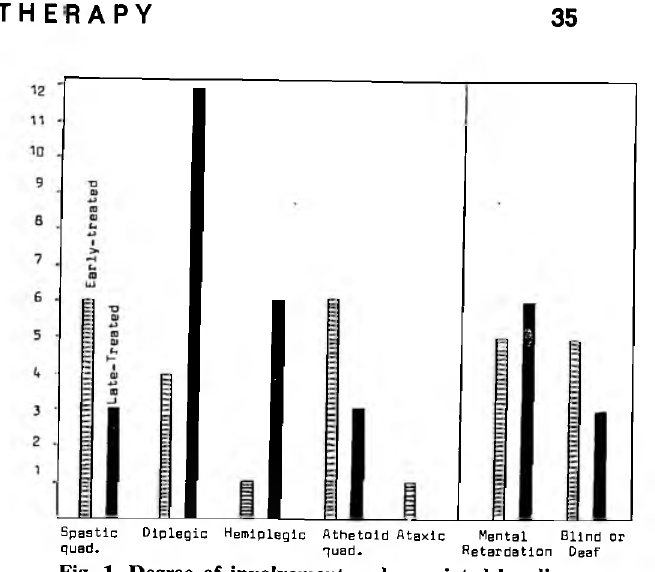
Fig. 1. Degree of involvement and associated